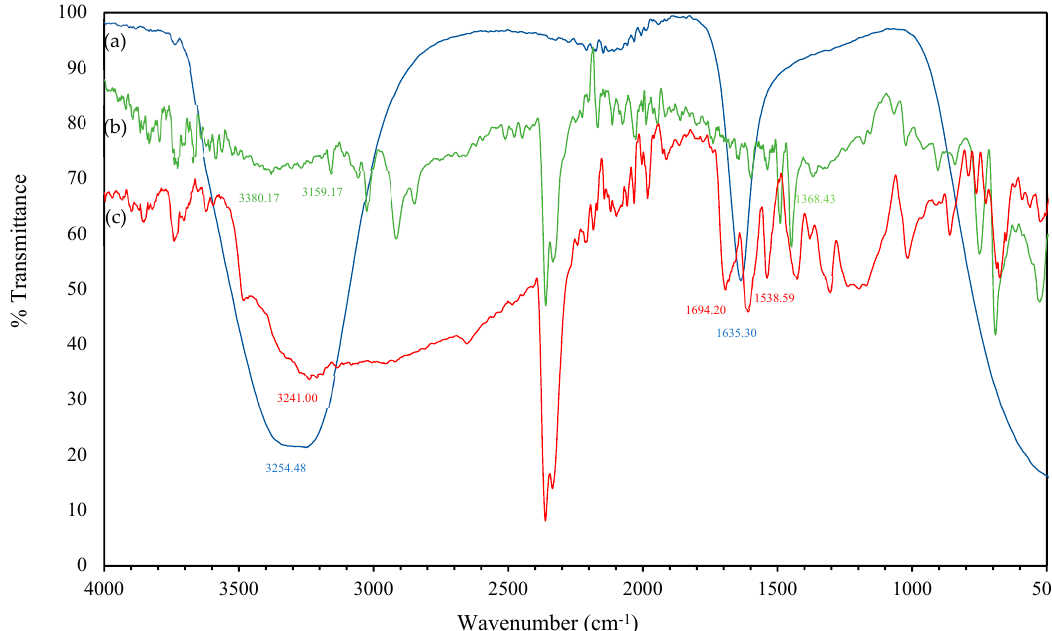
Figure 2. FTIR spectrum of ( a ) aqueous extract of E. elatior ; ( b ) purified AuNPs synthesised by the green synthesis method using the E. elatior extract, and ( c ) purified AuNPs synthesised by the citrate reduction method.